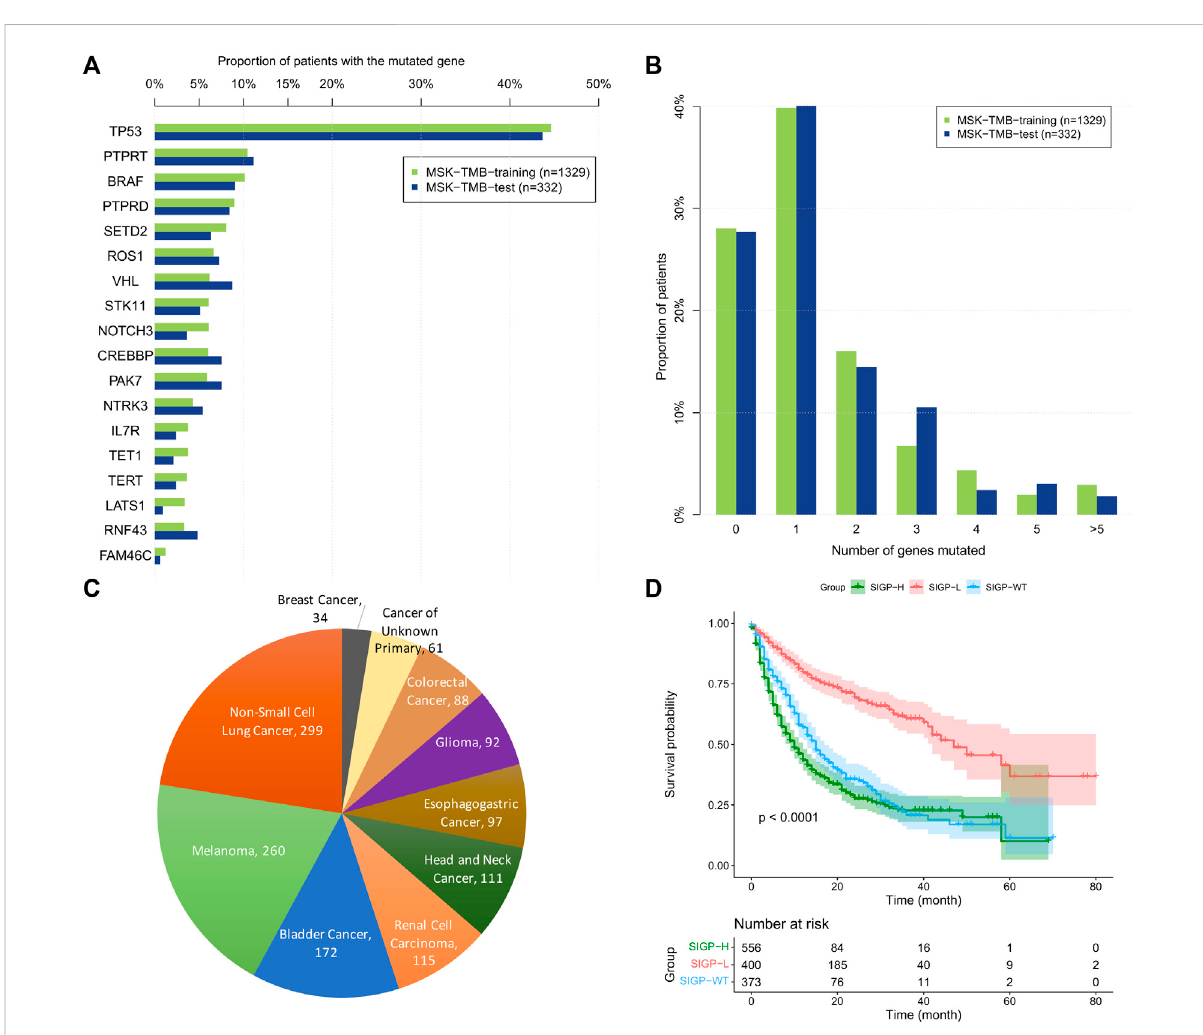
FIGURE 1 Theprevalence of18selectedgenes mutated amongpatients andtheproportionofpatients with thedifferentnumber ofgenesmutated inthe MSK-TMB-training cohort and the MSK-TMB-test cohort, the proportion of patients with different cancer types and Kaplan – Meier (KM) curves of SIGP in MSK-TMB-training. (A) Prevalence of the 18 selected genes mutated among patients; (B) Proportion of patients with the different number of genes mutated; (C) Proportion of patients with different cancer types in MSK-TMB-training ( n = 1329); (D) KM curves of SIGP in MSK-TMB-